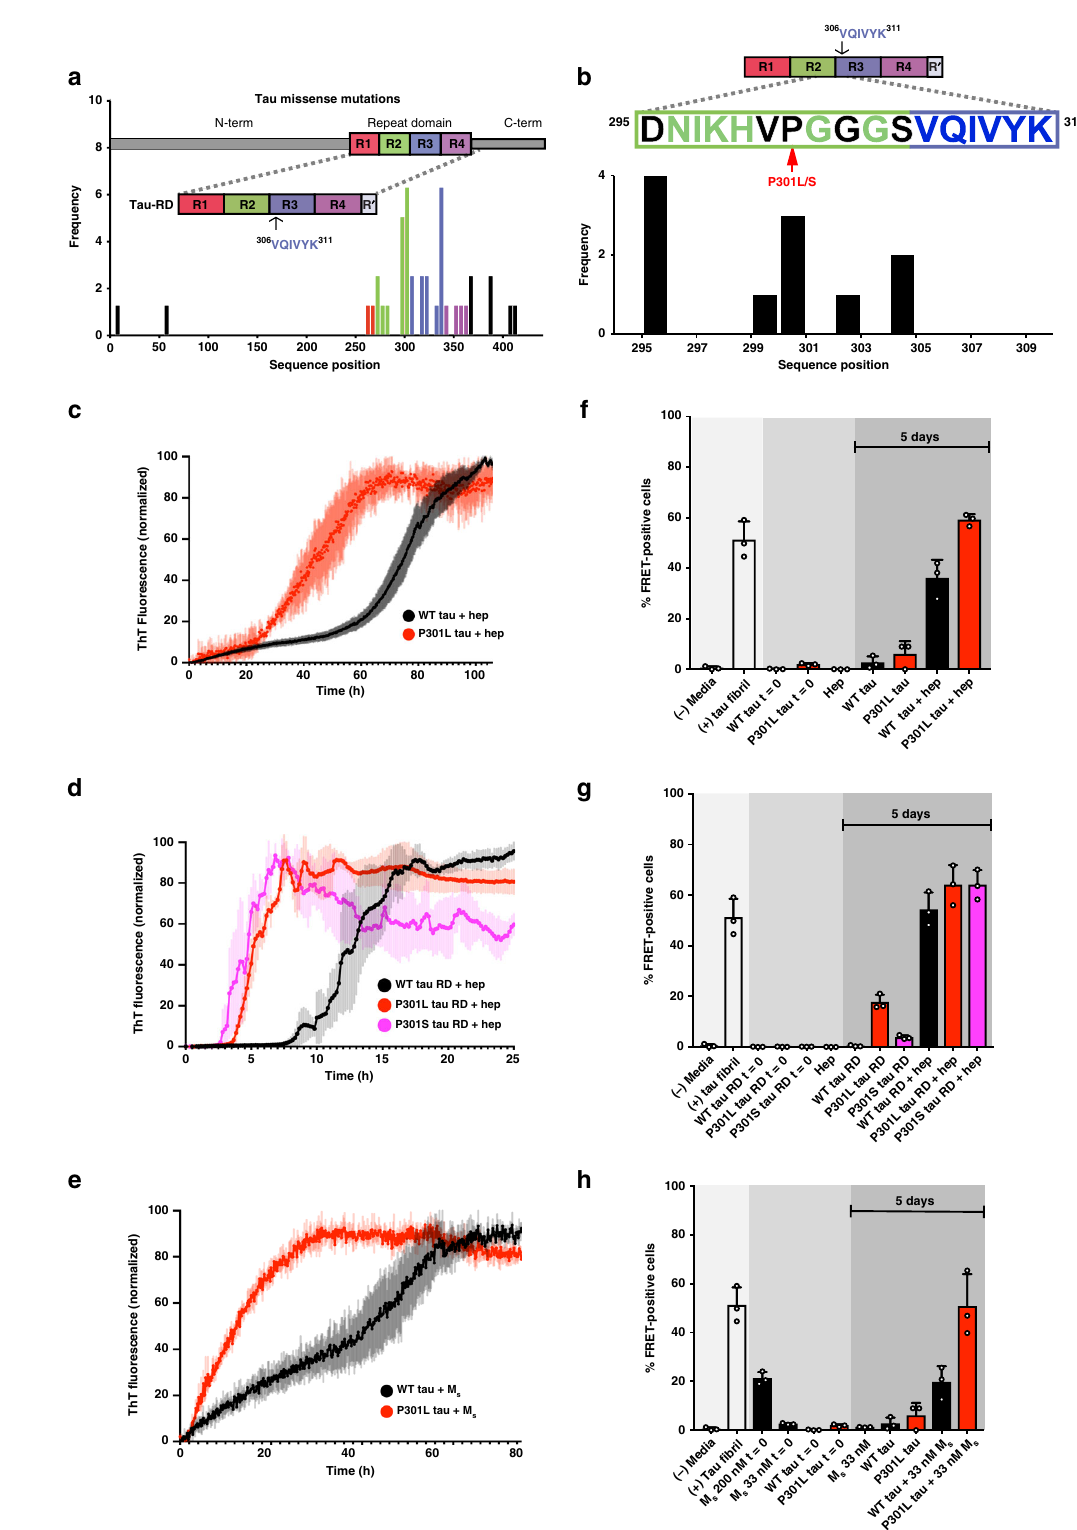
RD (WT tau RD, t 1/2 = 12.5 ± 0.2 h) (Fig. 1d and Supplementary Data 1). Consistently, we found that mutations at position 301 (from proline to either leucine or serine) increased aggregation rates by approximately twofold compared with WT in both FL tau and tau RD constructs. Thus, in vitro, tau RD recapitulates key aspects of aggregation observed in FL